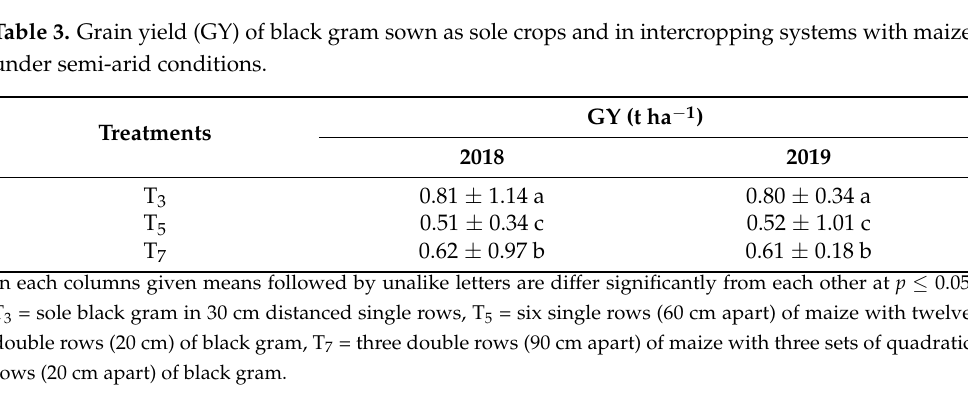
Table 4. Grain yield (GY) of green gram sown as sole crops and in intercropping systems with maize under semi-arid conditions.